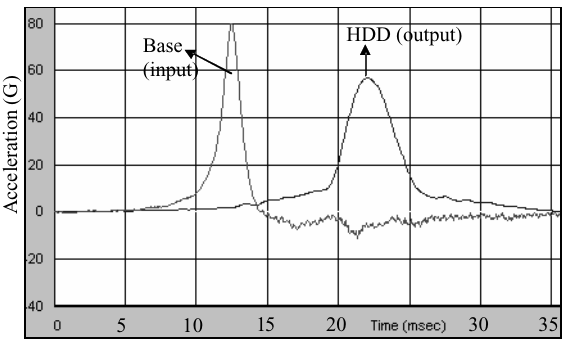
Fig. 18. HDD crash hazard test